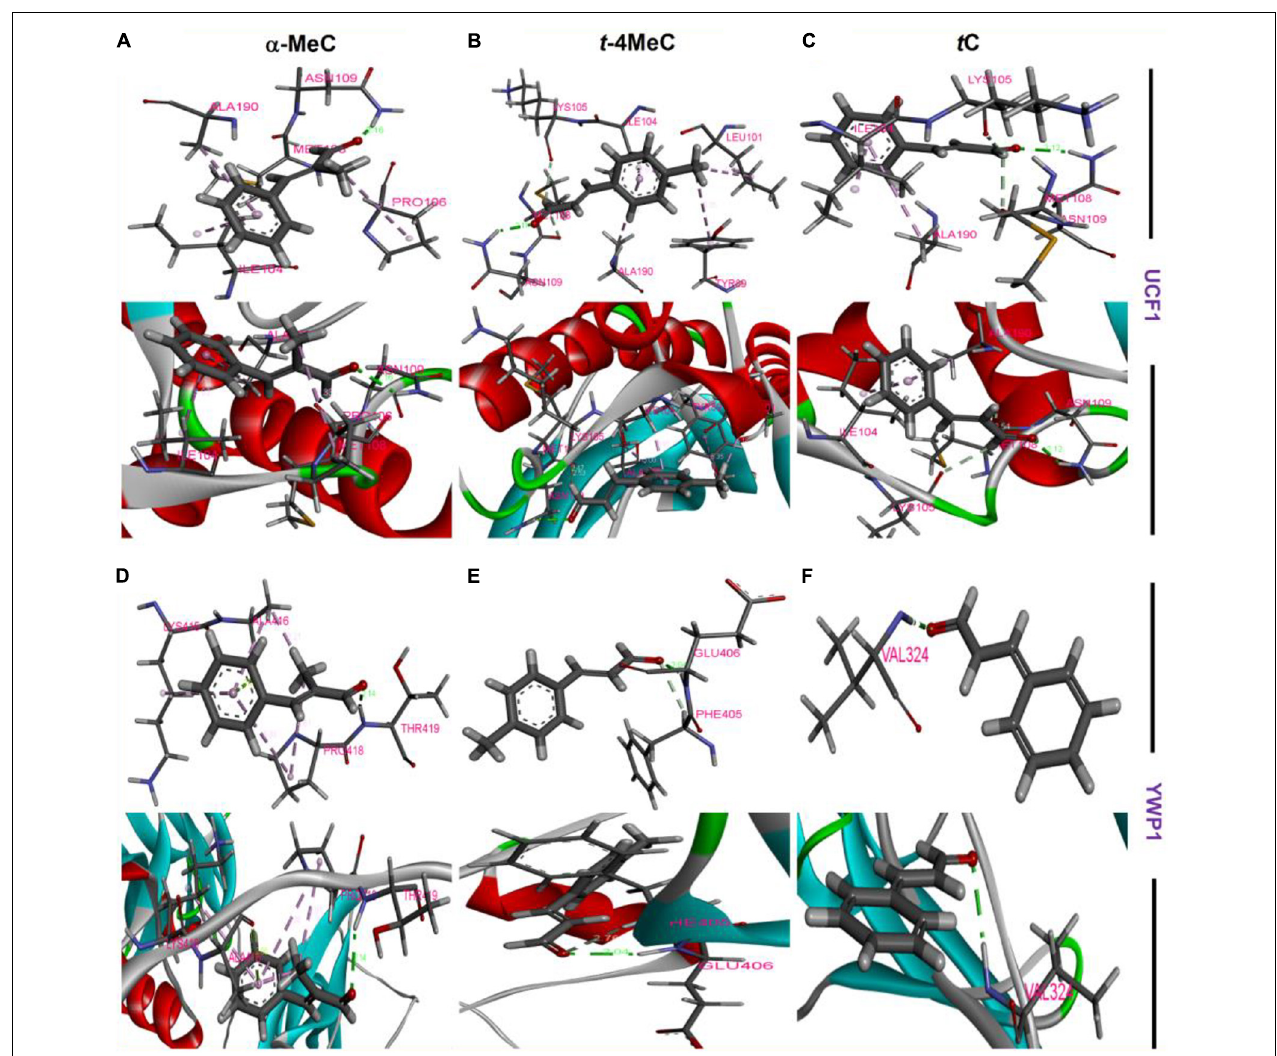
FIGURE 5 | Amino acid residue interactions between UCF1 receptor protein and α -methyl cinnamaldehyde ( α -MeC) (A) , trans- 4-methyl cinnamaldehyde ( t -4MeC) (B) , and trans- cinnamaldehyde ( t C) (C) , Amino acid residue interactions between YWP1 receptor protein and α -methyl cinnamaldehyde ( α -MeC) (D) , trans- 4-methyl cinnamaldehyde ( t -4MeC) (E) , and trans- cinnamaldehyde ( t C) (F)